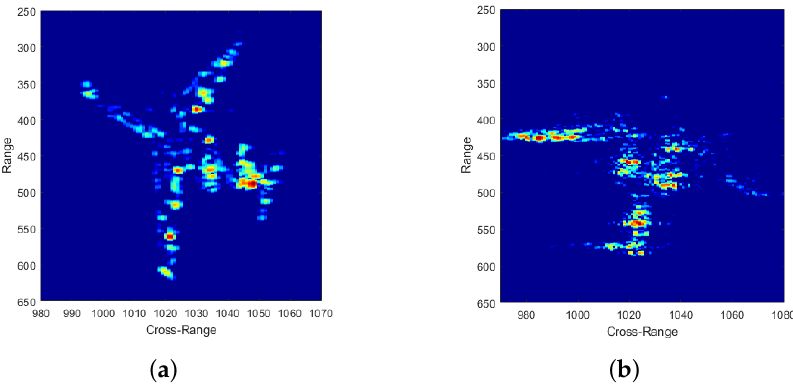
Figure 7. High resolution RD imaging results with Full echo of data ( a ) I and ( b )